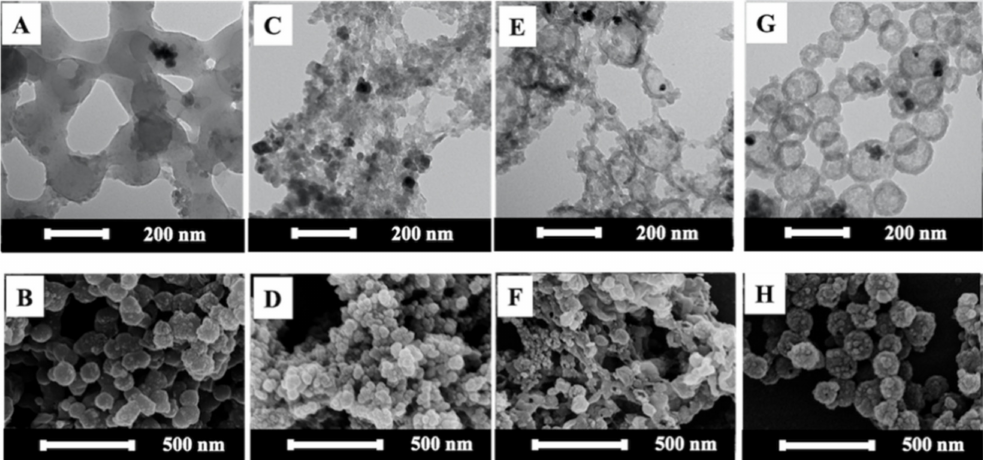
Figure 6. TEM and SEM images of spherical ZPP using MMA as a main monomer and varying DVB crosslinking agent from 0% ( A , B ), 1.0%( C , D ), 5.0% ( E , F ), and 10.0% ( G , H